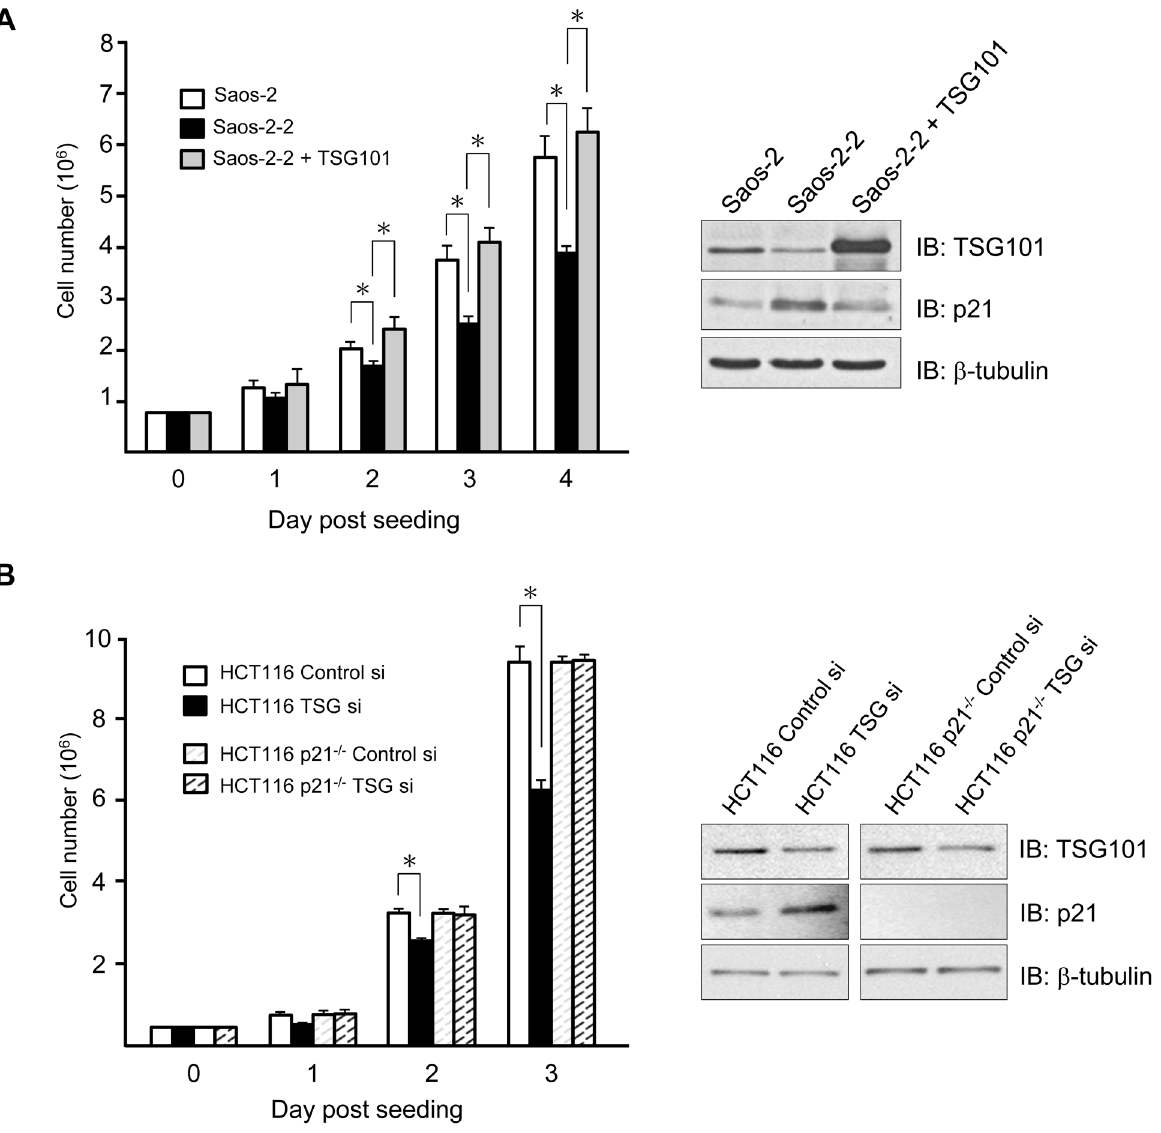
Figure 2. TSG101 deficiency causes cell growth defect via p21. (A) Left, proliferation of Saos-2, Saos-2-2, and Saos-2-2 cells expressing ectopic TSG101 was measured by counting viable cells for 4 consecutive days. Right, TSG101 and p21 protein levels were assessed by Western blot analysis in indicated cells. b -tubulin serves as a loading control. (B) HCT116 and isogenic HCT116 p21 -/- cells were subjected to TSG101-specific siRNA (TSG101 si) knockdown and changes in TSG101 and p21 protein levels relative to samples treated with control siRNA (Control Si) were analyzed by Western blot (Right). Cell growth was monitored for 3 days (Left). Results were the average of three independent experiments done in triplicate (* P , 0.05, Student’s t